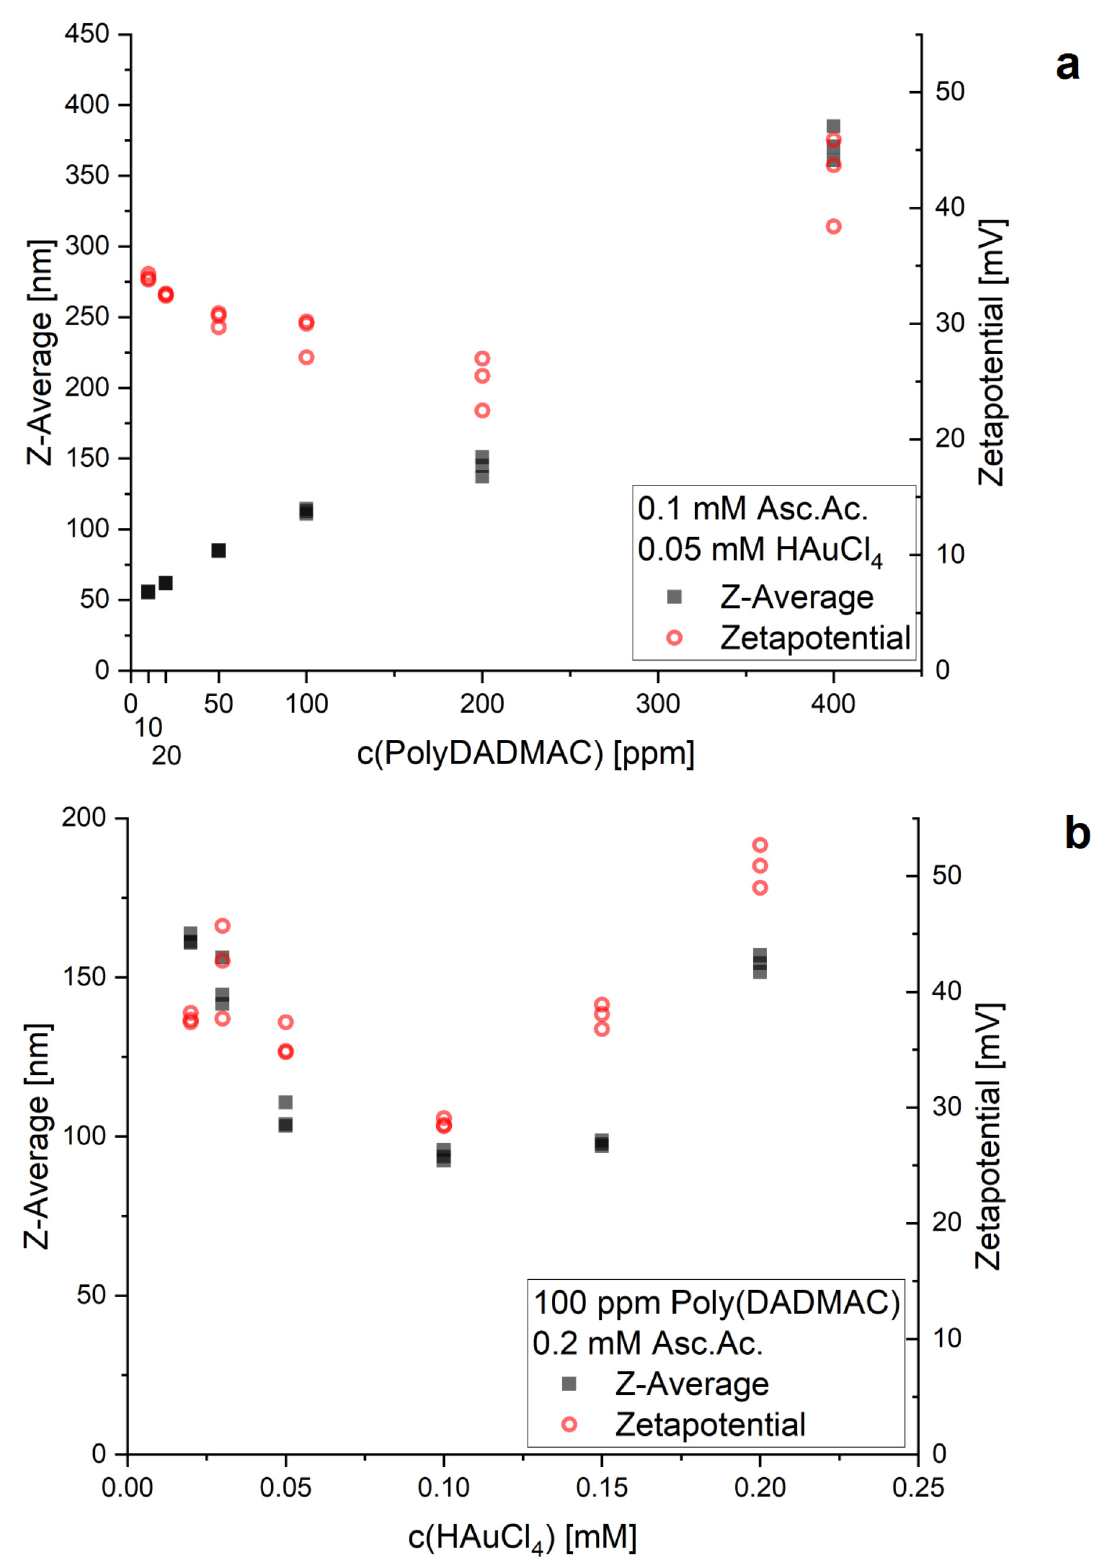
Figure 2. Dependence of the main particle fraction in the DLS spectra on reactant concentrations: ( a ) dependence on HAuCl 4 concentration; ( b ) dependence on poly-DADMAC concentration.